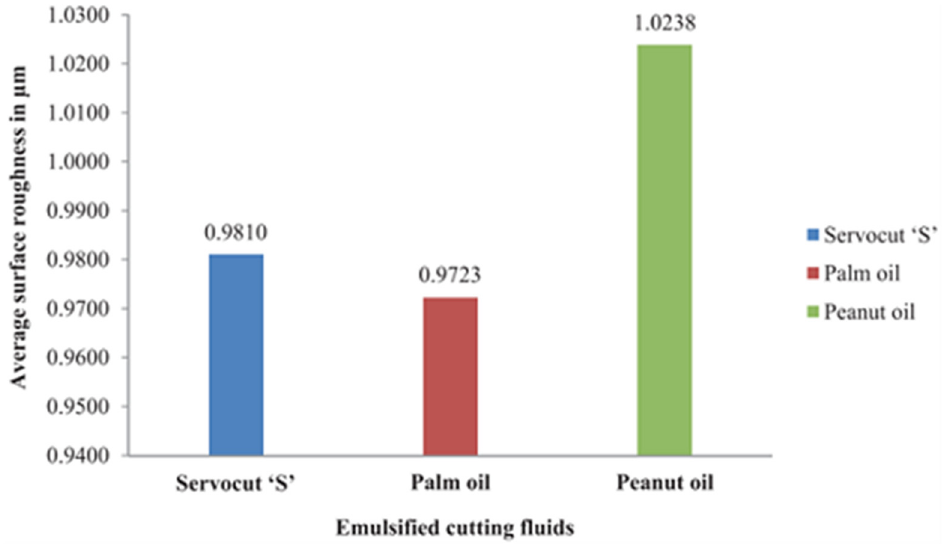
Figure 5. Surface Roughness Variation under Different Cutting fluids [86].